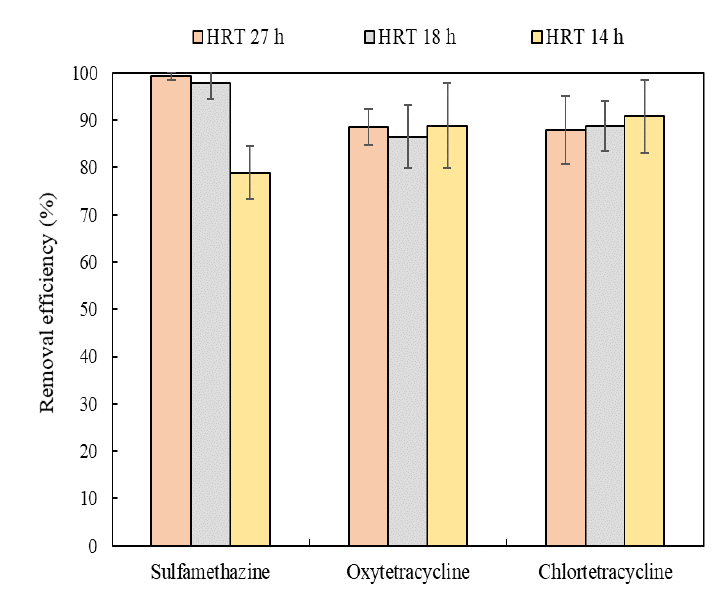
Figure 4. Removal e ffi ciency of antibiotics according to HRT ( n = 9). Sulfathiazole was not detected in Figure 4. Removal efficiency of antibiotics according to HRT (n = 9). Sulfathiazole was not detected in any of the sampling any of the sampling campaigns.